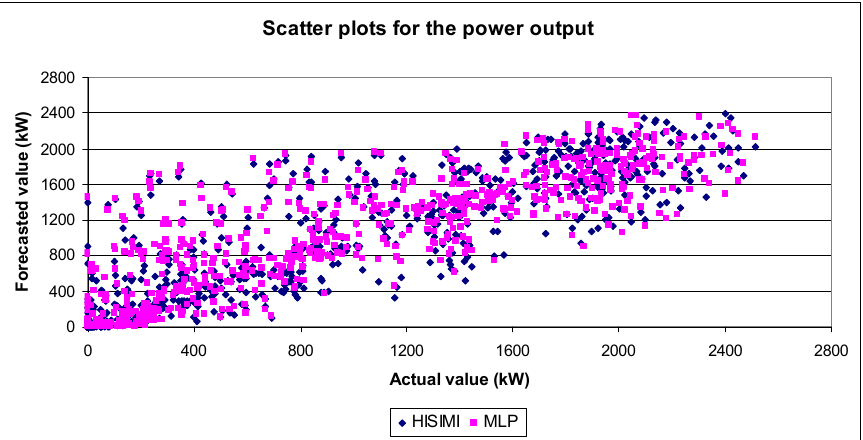
Figure 7. Scatter plots of forecasted values versus actual values of power output for HISIMI and MLP models.